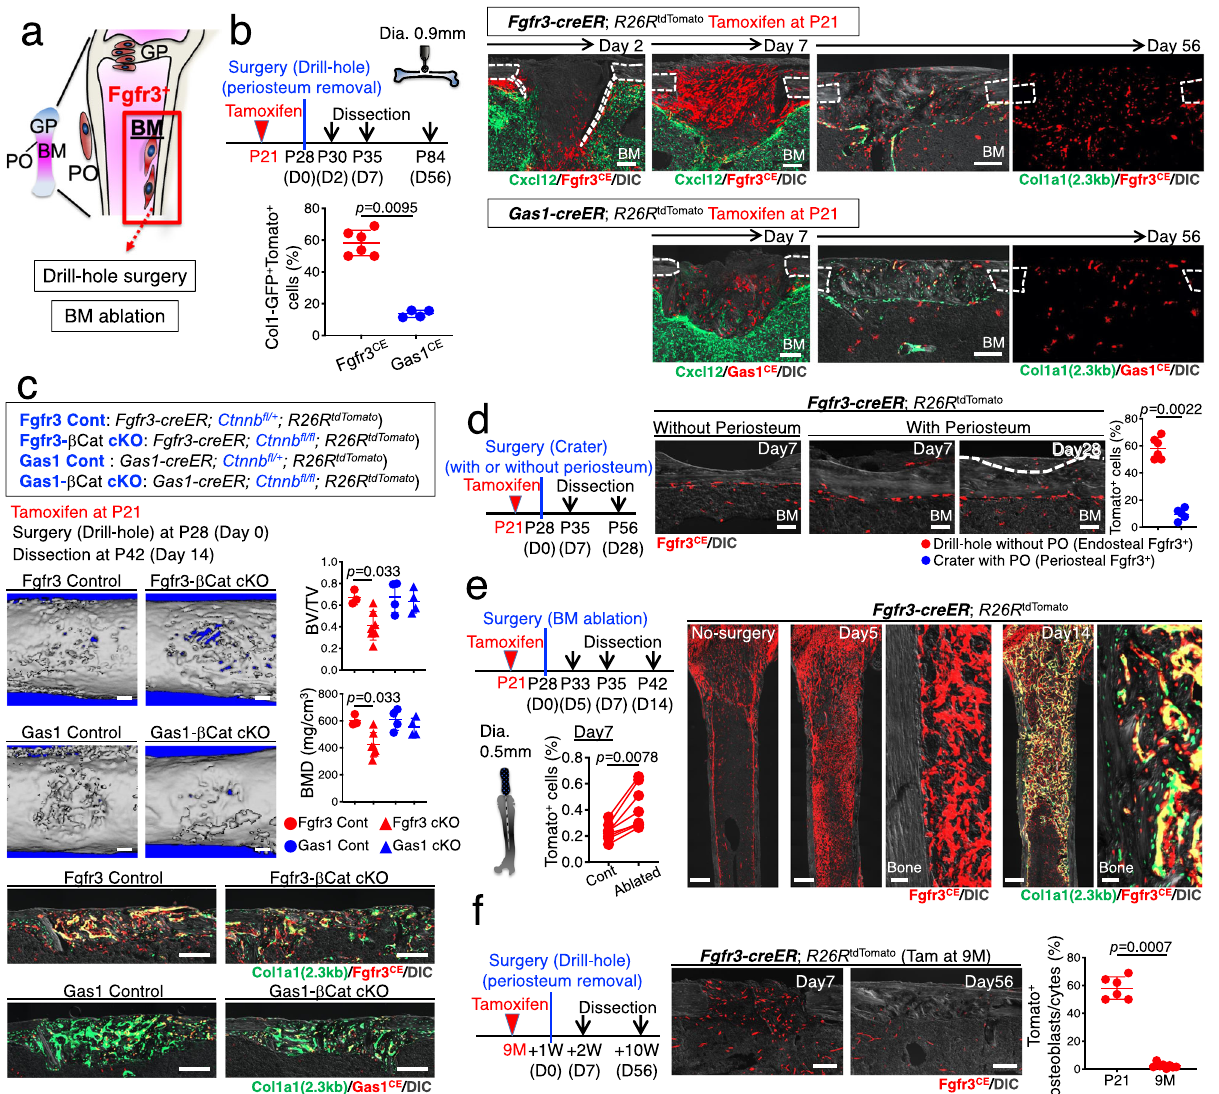
Fig. 5 | Fgfr3 + endosteal stem cells dictate active osteogenesis in injury. a DiagramofexperimentalapproachestointerrogateFgfr3 + endostealstromalcells in injury. b Drill-hole injury experiments. Timeline and histological analyses. Fgfr3- creER; R26R tdTomato (upper) or Gas1-creER; R26R tdTomato (lower) cortical bone at 2, 7, and56daysaftersurgerywith Cxcl12-GFP (Day2and7)or Col1a1-GFP (Day56).BM: bonemarrow.Scale bar:200 µ m. n =6(Fgfr3 CE atday56), n =4(others).Lowerleft: percentage of Col1a1-GFP + tdTomato + cells among totalCol1a1-GFP + cells at 56days after surgery. Two-tailed, Mann – Whitney ’ s U -test. c Conditional inactivation of Wnt/ β -cateninsignalingindrill-holeinjury.3D- μ CTimages(upper)andhistological images (lower) of Fgfr3 Control, Fgfr3- β Cat cKO, Gas1 Control, and Gas1- β Cat cKO injured femur diaphyseal cortical bones at 14 days after surgery. Bone volume/ tissue volume (BV/TV) and bone mineral density (BMD) of the injured area (right). Scalebar: 200 µ m. n =3 (Fgfr3Control), n =5 (Fgfr3- β cat cKO), n =4 (Gas1 Control, Gas1- β cat cKO) mice. Two-tailed, Mann – Whitney ’ s U -test. d Cortical surface crater injury experiments. Injured Fgfr3-creER; R26R tdTomato cortical bone at 7 days (with or without periosteum) and 28 days (with periosteum) after surgery. BM: bone mar- row. Scale bar: 200 µ m. n =7 (day 7 without periosteum), n =4 (day 7 with